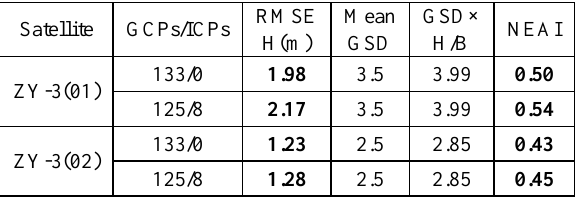
Table 4. The normalized elevation accuracy index of the ZY-3 triplet stereo images